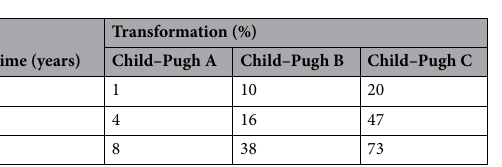
Table 2. Rate of hepatocarcinogenesis of dysplastic nodules by Child–Pugh grade.